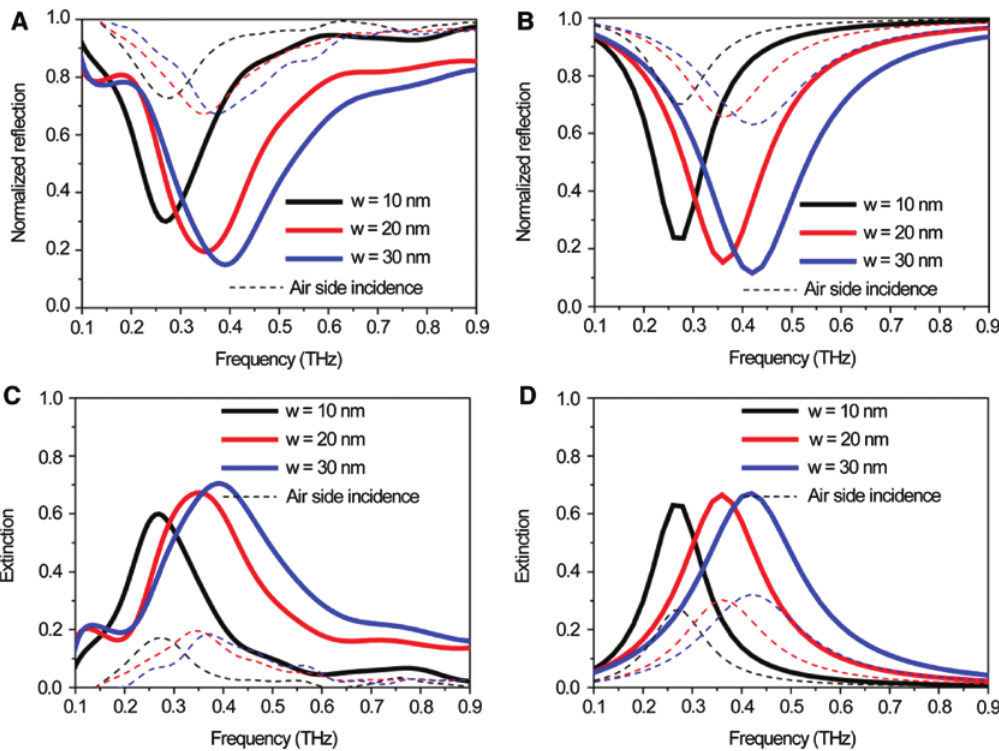
Figure 4: Reflection spectra from the nanogaps. Substrate-side incidence induces much larger reflection dips for both (A) experiments and (B) calculations. Corresponding extinction spectra for (C) experiments and (D) calculations are also shown.